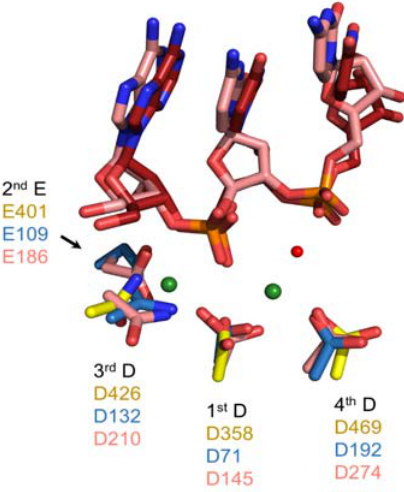
Figure 6. Alignment of RNase H active sites from Ty3 RT (PDB ID 4OL8, REF), Bacillus halodurans RNase H1 (PDB ID: 1ZB1, REF), and human RNase H1 (PDB ID: 2QK9, REF). Residue carbon atoms are shown in yellow, blue, and salmon, respectively. RNA strands from human and bacterial RNases H1 are shown in salmon and red, and two catalytic Mg ++ ions from the Bh-RNase H1 structure are depicted as green spheres. The attacking nucleophilic water is shown as a red sphere.